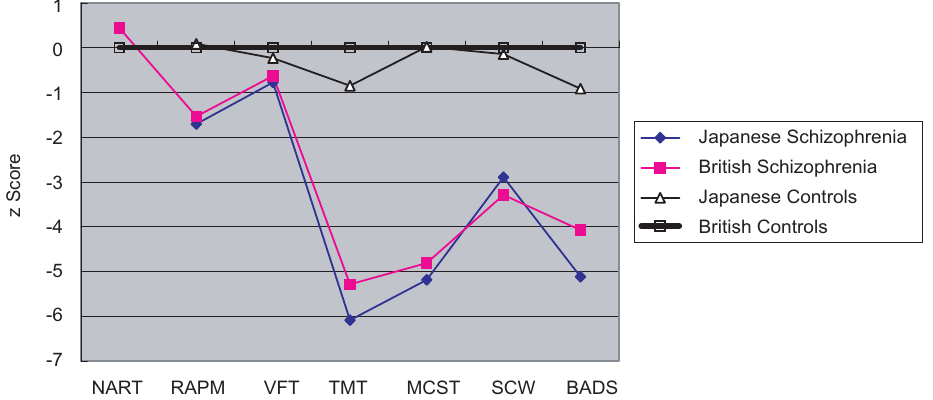
Fig. 1. The profiles of impairment: the Japanese and British patients, the Japanese and British control subjects (standard deviations from mean of the British control group). Note. NART = National Adult Reading Test [42]; RAPM = Raven Advanced Progressive Matrices [46]; VFT = Verbal Fluency Test [36]; TMT = Trail Making Test [47]; MCST = Modified Card Sorting Test [41]; SCW = Stroop Colour Word Test [53]; BADS = Behavioural Assessment of Dysexecutive Syndrome